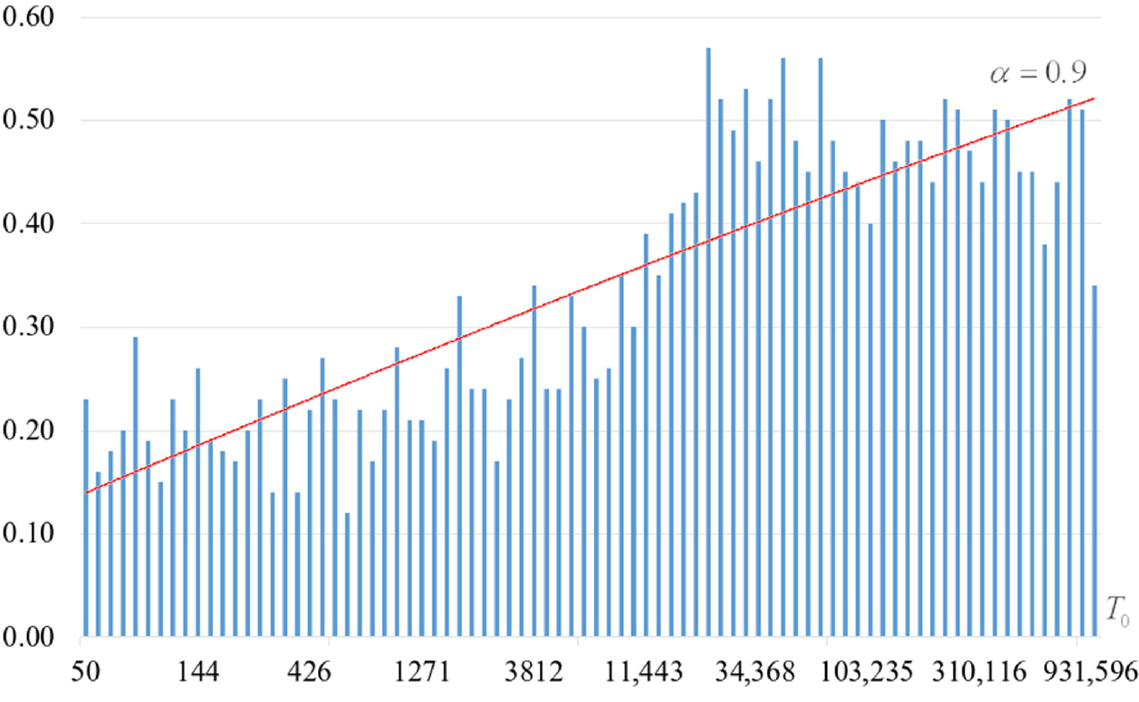
Figure 5. The probability of forming the target S-box at 𝛼 = 0.9 .